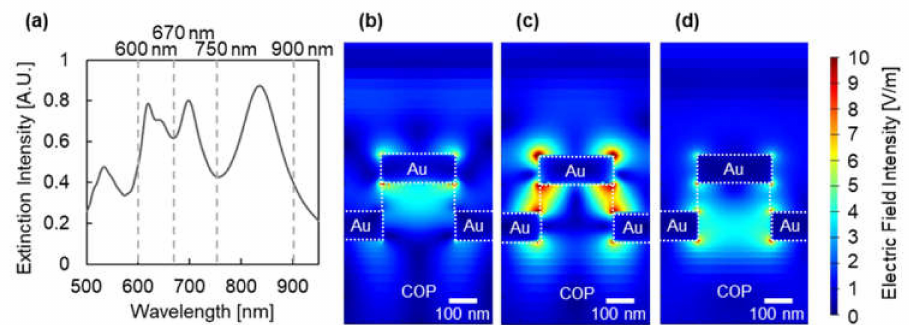
Figure 8. ( a ) Simulated spectra of plasmonic device with 230 nm diameter, 100 nm Au thickness, and 0 nm pit depth. The gray dashed lines at 600, 670, 750, and 900 nm wavelengths in the graph indicates the estimated divisions of extinction peaks. Cross-sectional electric field distribution of plasmonic devices at peak wavelengths of ( b ) 641 nm, ( c ) 698 nm, and ( d ) 835